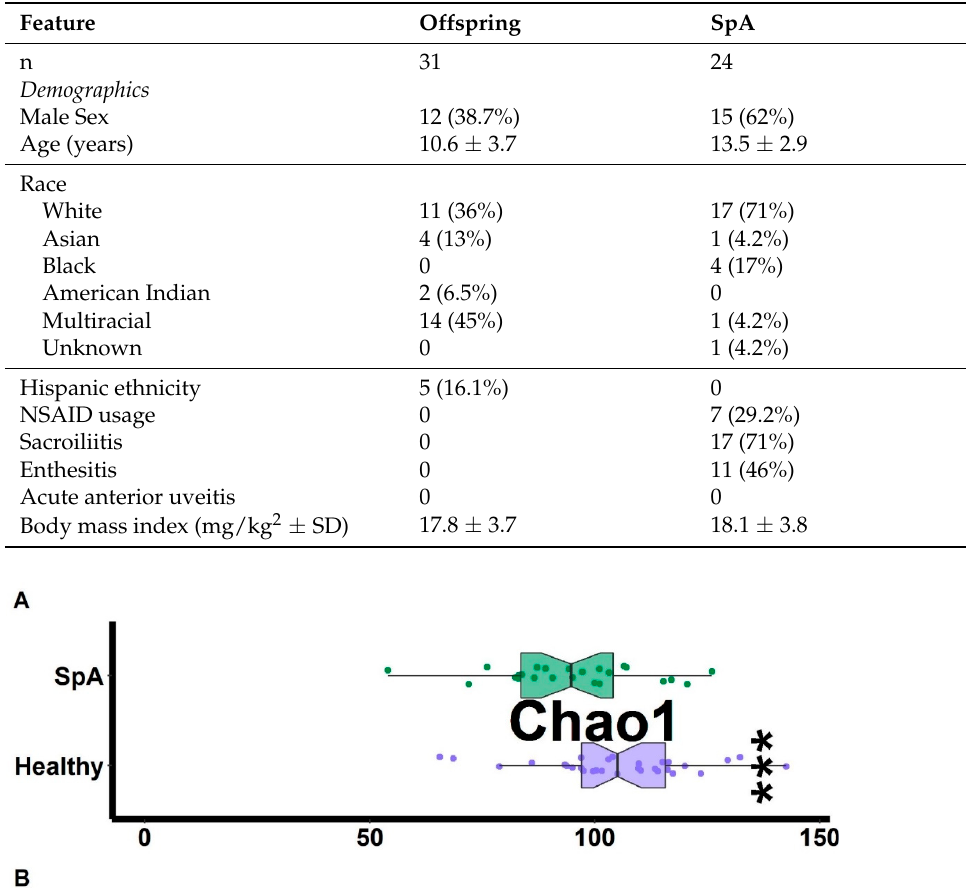
Table 4. Demographic and clinical variables of the HLA-B27+ study population. Abbreviations: NSAIDs, nonsteroidal anti-inflammatory drugs, SpA; spondyloarthritis. The number of offspring is one less than that reported in Table 1, as the subject with SpA was included in the SpA group.